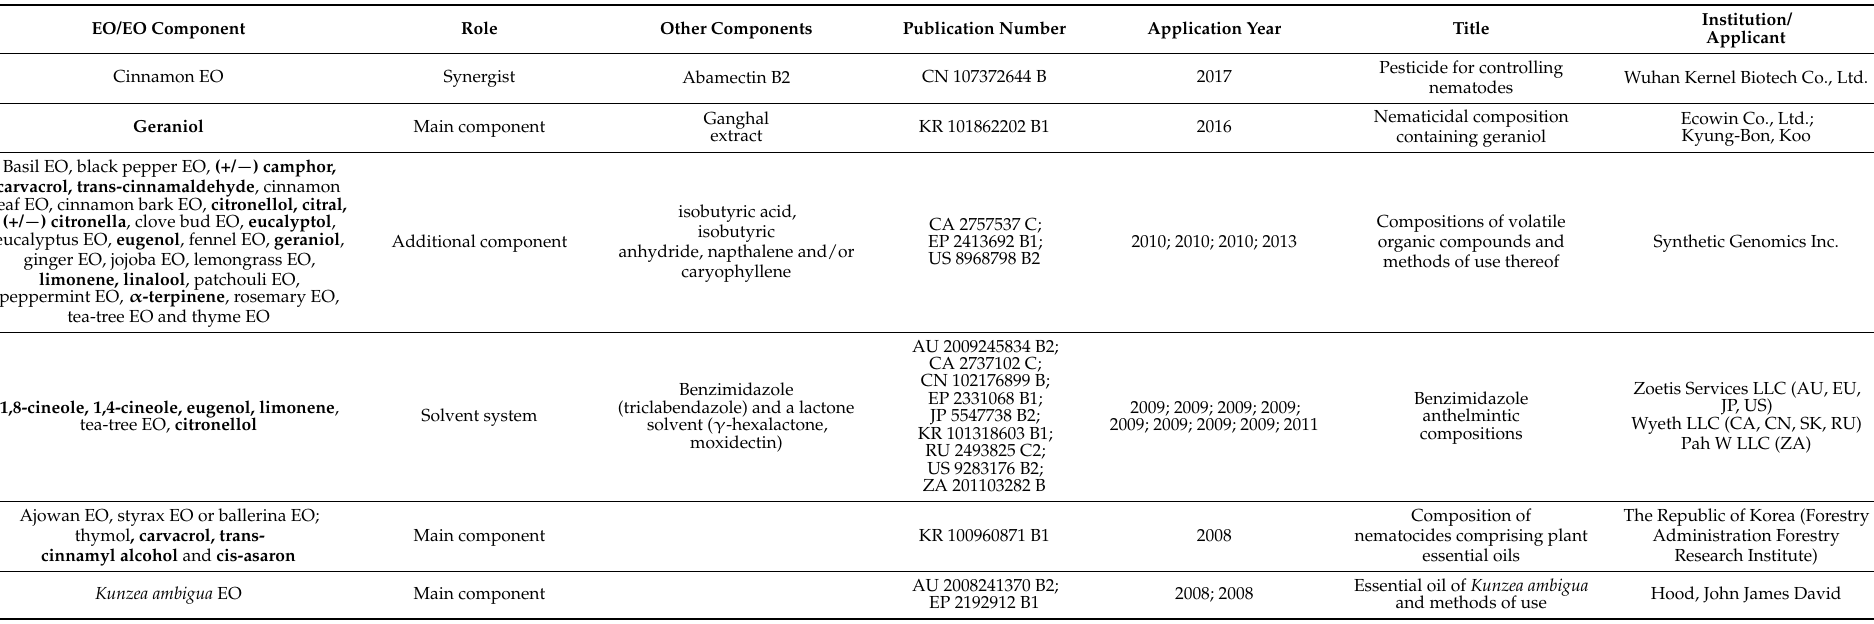
Table 3. Patented anthelmintic essential oils or essential oil components as of July